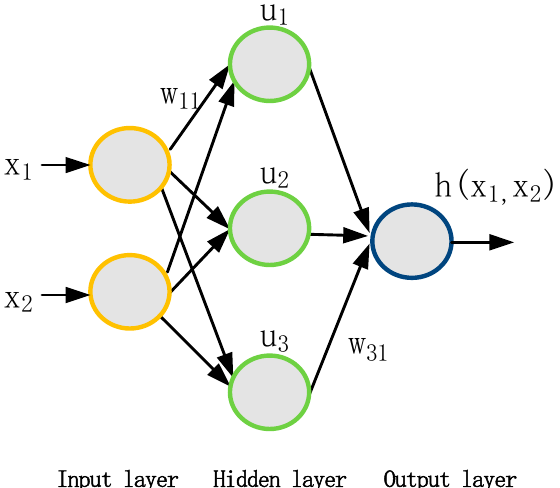
Figure 1. Typical FNN with 3 layers, which are the input layer, the hidden layer and the output layer, respectively. There are 3 units in the hidden layer.